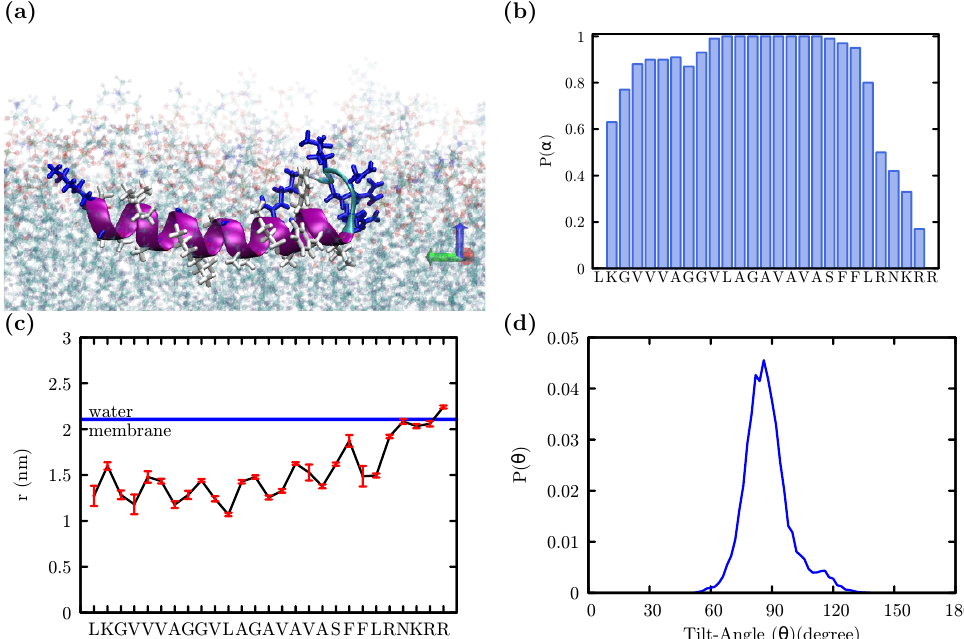
Figure 3. Analysis of AA-REX results. ( a ) Fis1 TA adopts a dominantly α -helical structure within the membrane. ( b ) Sequence specific α -helix propensity. ( c ) Average depth of the residues with respect to membrane/water interface. ( d ) Angle between the helix axis and the membrane